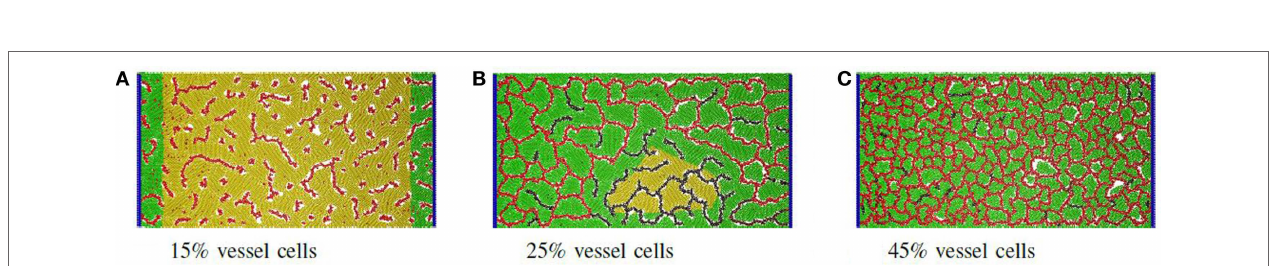
FIGURE 3 | Proportion of vascular cells: example of self-organized networks from different proportions of vessel and producer cells . (A) At 15%, only isolated and dysfunctional vessels are formed. (B) At 25%, regions with disconnected vessels become common, leading to areas of inactive producer cells (yellow). In this case, darker vascular cells signify very low or no nutrient flow. (C) At higher densities such as 45%, many small lacunae are formed and all producer cells are